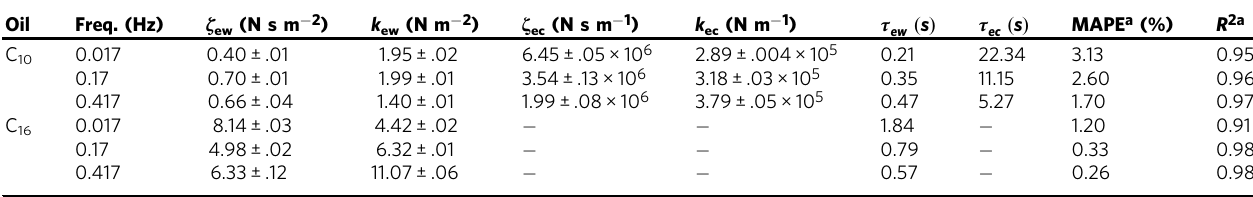
Table 1 Damping and stiffness parameters for decane (C 10 ) and hexadecane (C 16 ) Oil Freq.